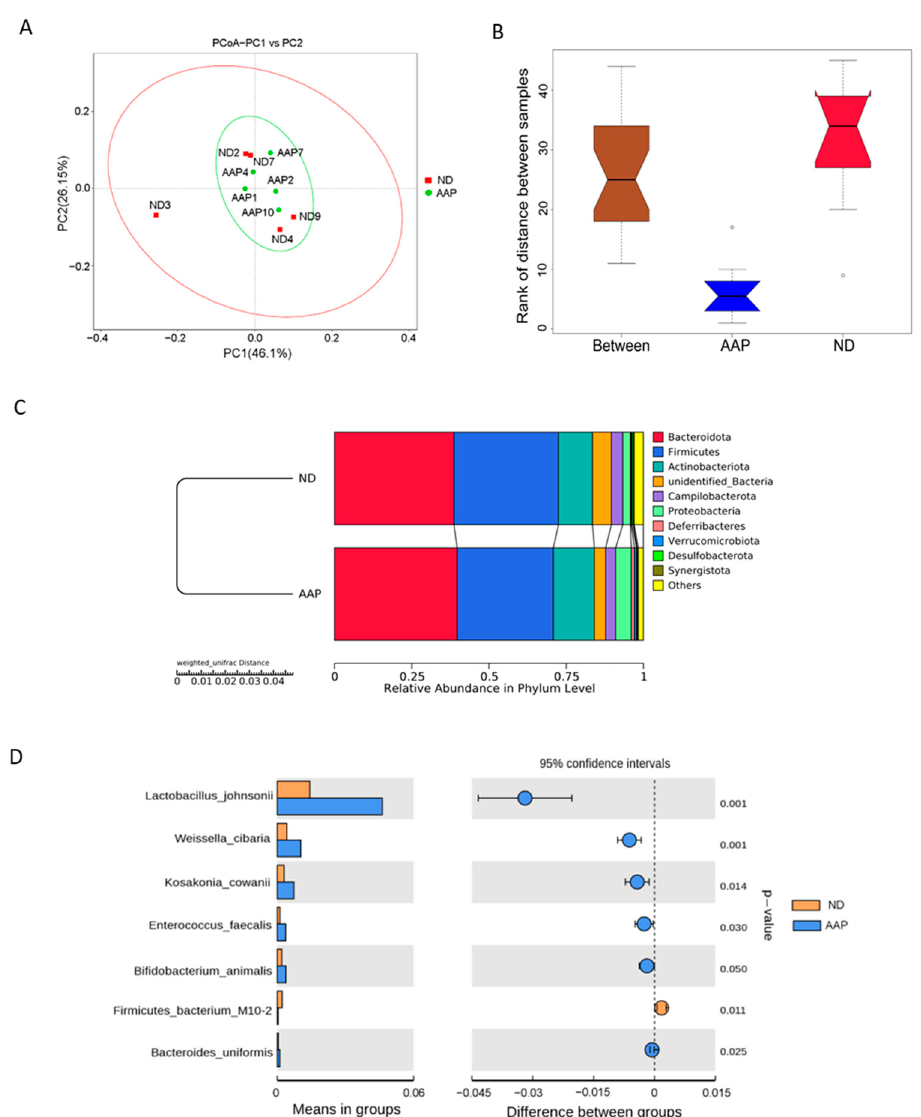
Figure 2. The effects of Auricularia auricula polysaccharides on β diversity of intestinal flora in mice. ( A ) Principle component analysis (PCoA) based on weighted unifrac distance; ( B ) Anosim difference analysis between groups; ( C ) Unweighted pair group method with arithmetic mean (UPGMA) clustering tree based on weighted unifrac distance; ( D ) Group species difference analysis chart of Student’s t test at the species level. ND = normal diets; AAP = Auricularia auricula polysaccharides. Data presented as mean ± SD, n = 5.